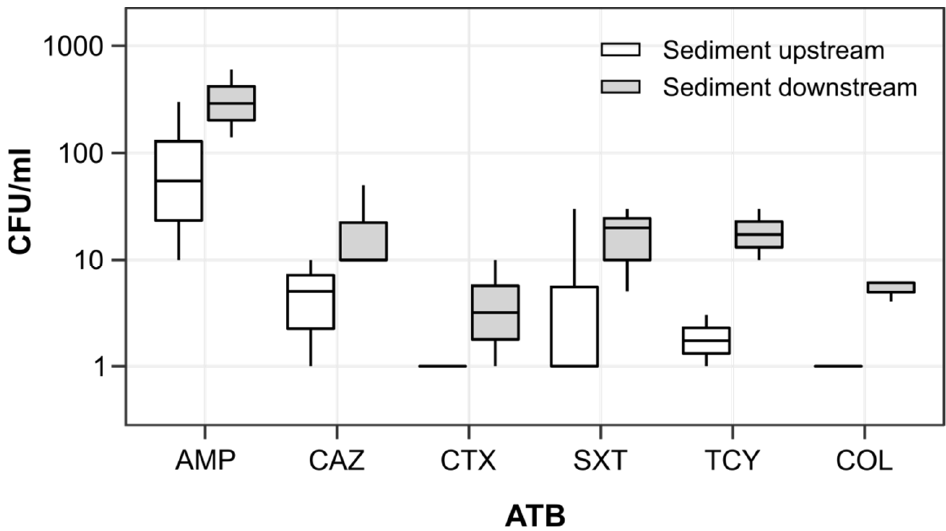
Figure 12. Normalized fold gene expression levels of ARGs in the sediment samples taken upstream and downstream of the WWTP. ● indicate data points located outside whiskers of the Tukey's boxplot (outliers).